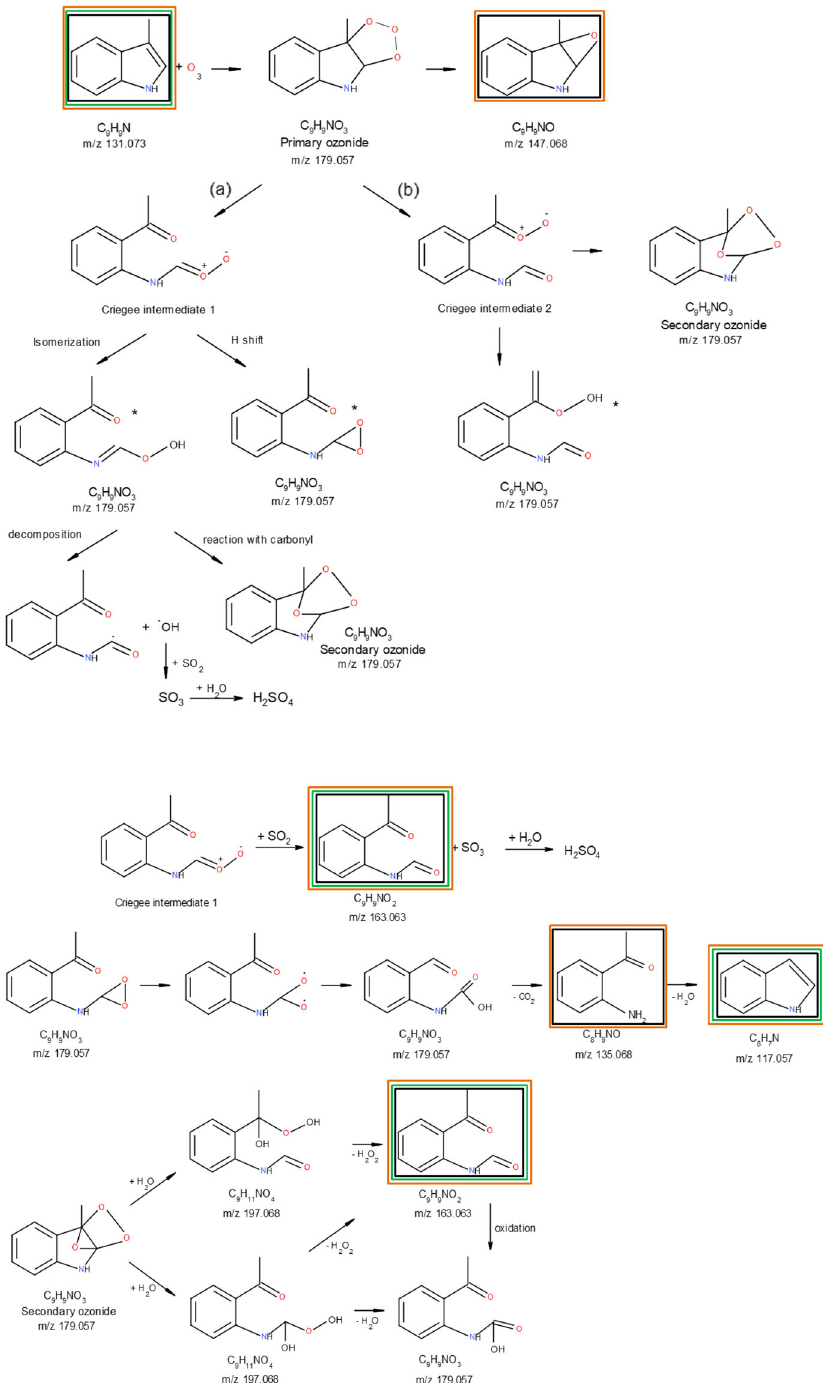
Fig. 2 Proposed mechanism of skatole ozonolysis. The compounds detected by PTR-ToF-MS are framed in black, those detected by GC-MS in green, and those detected by UHPLC-HRMS in